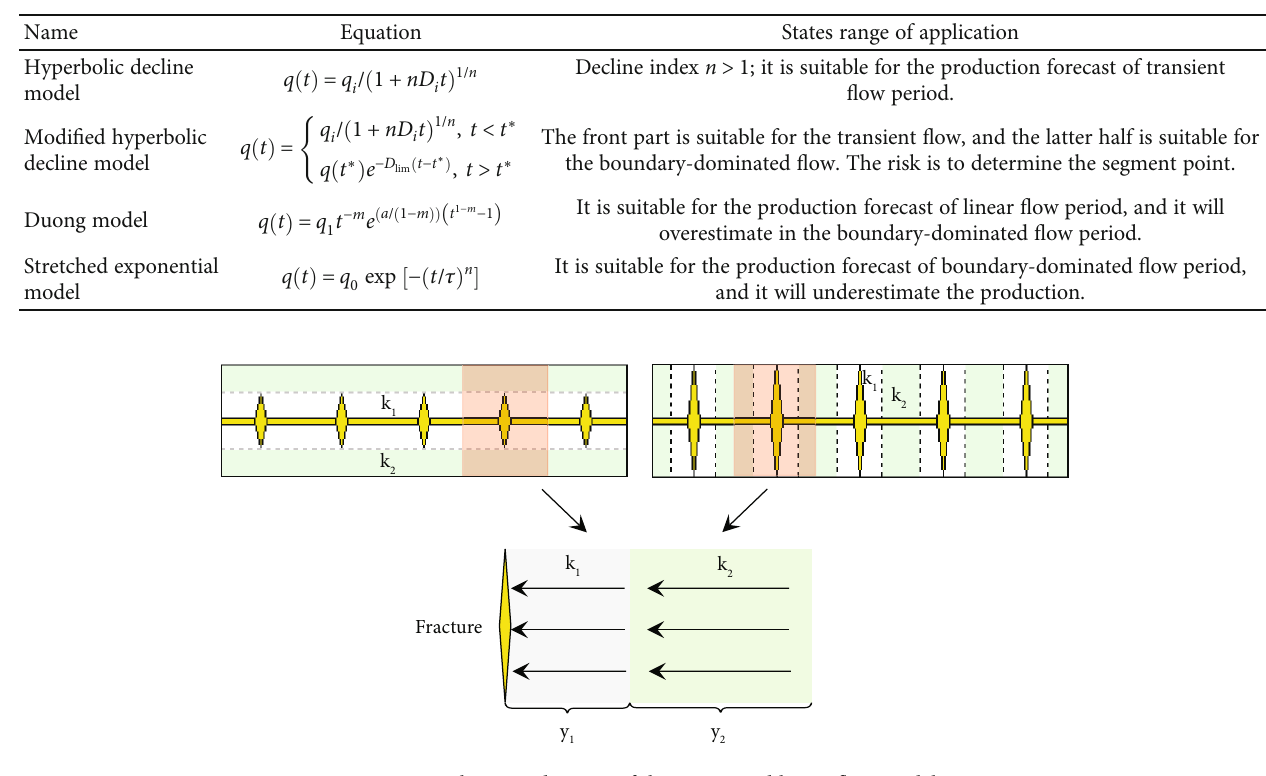
Table 1: The comparison of the primary decline model.